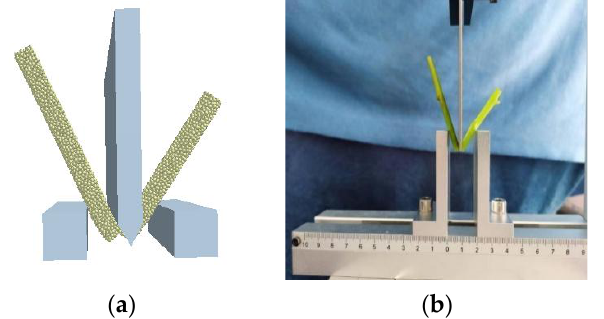
Figure 7. Three-point bending failure test of sweet potato vine stem: ( a ) bending failure simulation model; ( b ) bending failure test. Table 2. Discrete element simulation parameter values.